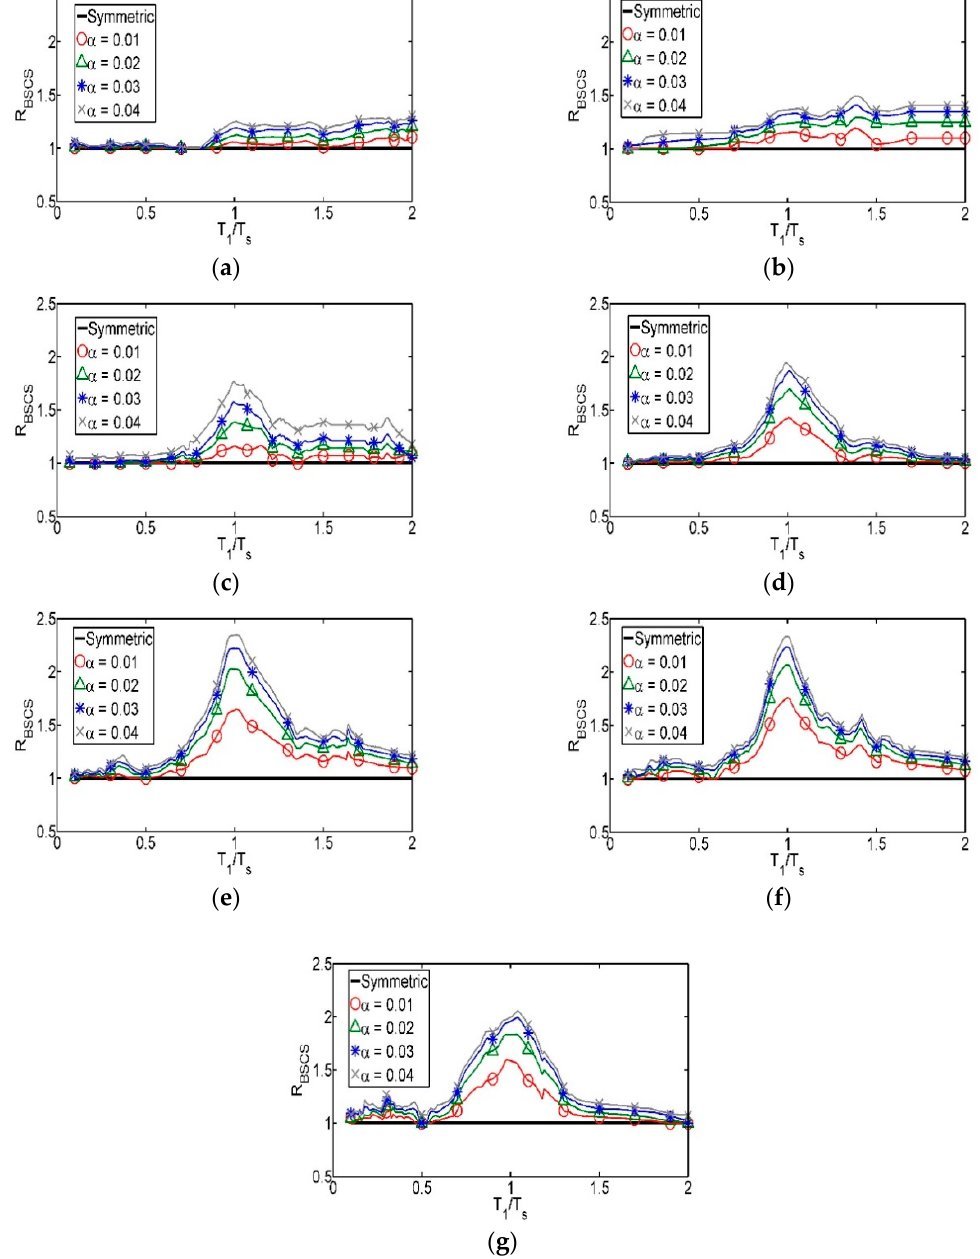
Figure 7. Parameter R BSCS corresponding to ( a ) Zone A; ( b ) Zone B; ( c ) Zone C; ( d ) Zone D; ( e ) Zone E; ( f ) Zone F and ( g ) Zone G, for different values of α , and µ = 2.